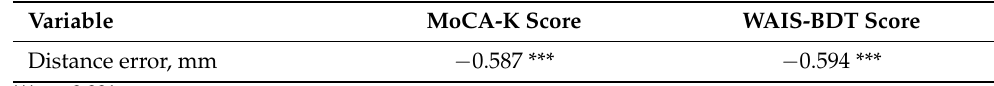
Table 4. Concurrent validity of the SCT-VR ( n =